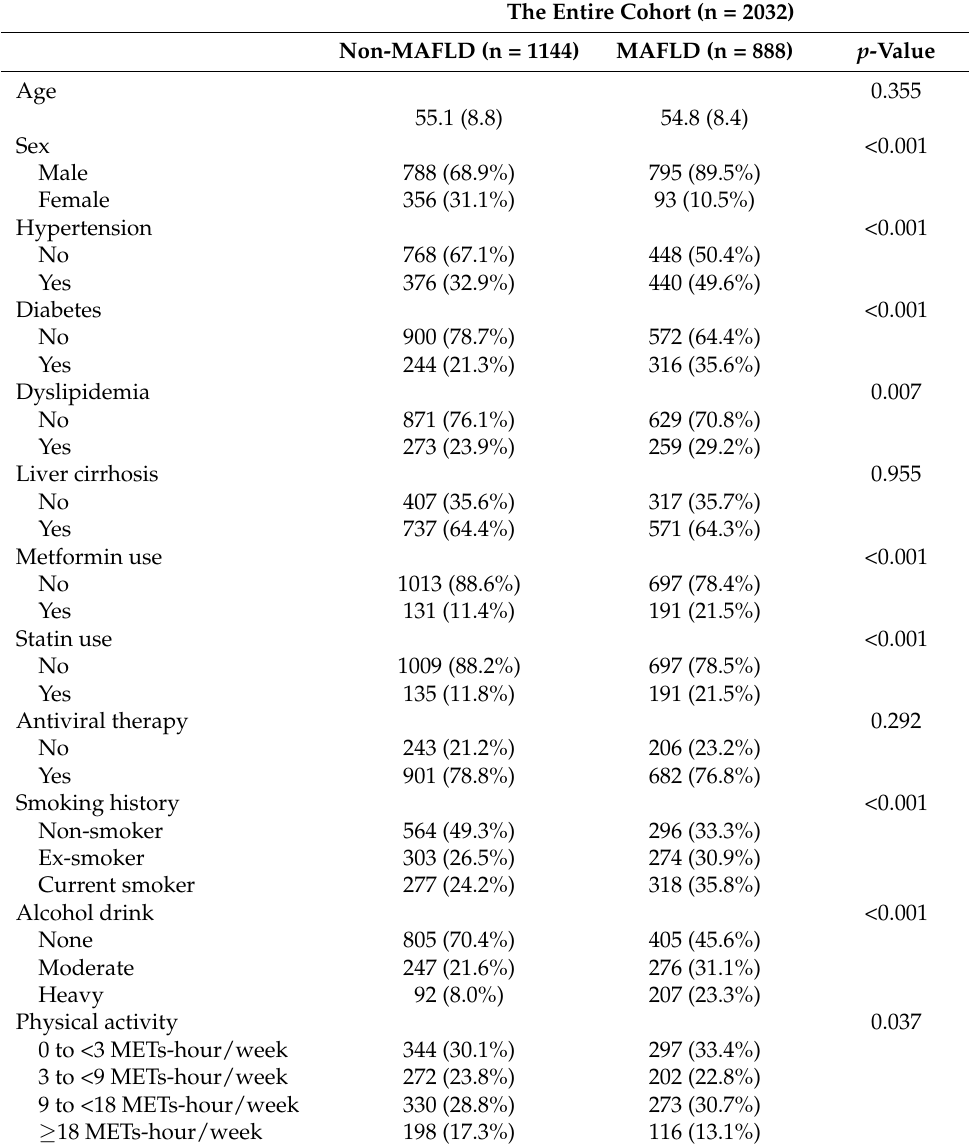
Table 1. Of 2032 patients, 1576 patients received health examinations before surgical resection, while 456 patients received health examination after surgical resection. The MAFLD group (n = 888) had a significantly higher prevalence of male sex, hypertension, diabetes, dyslipidemia, metformin and statin use, current smoking, alcohol consumption, and physical inactivity than the non-MAFLD group (n = 1144; all p < 0.05). Table 1. Baseline Characteristics of Chronic HBV participants stratified by MAFLD. The Entire Cohort (n =